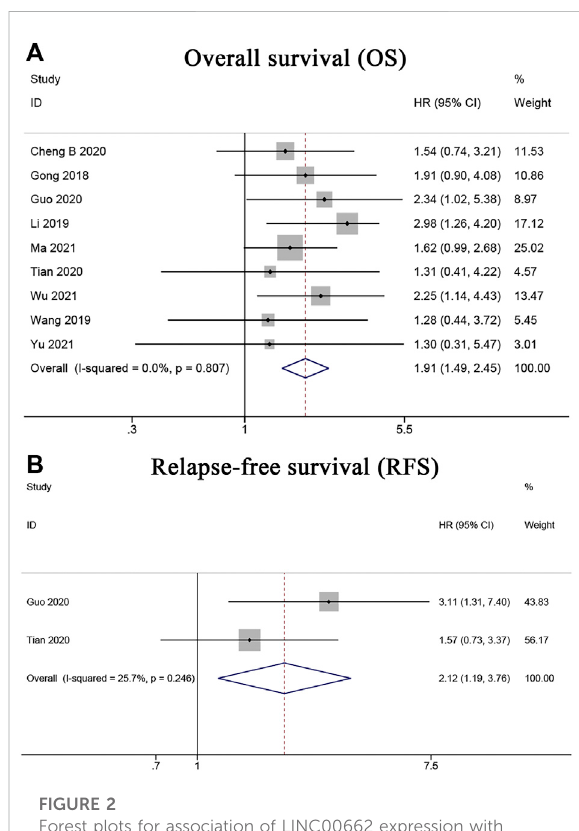
FIGURE 2 Forest plots for association of LINC00662 expression with survival. (A) Overall survival. (B) Relapse-free